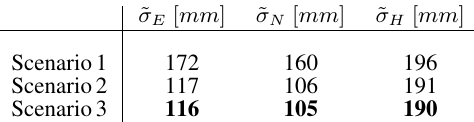
Table 1. Median standard deviations ( ˜ σ E , ˜ σ N and ˜ σ H ) of the 3D coordinates of the tie points in East, North and Height, in the different scenarios.